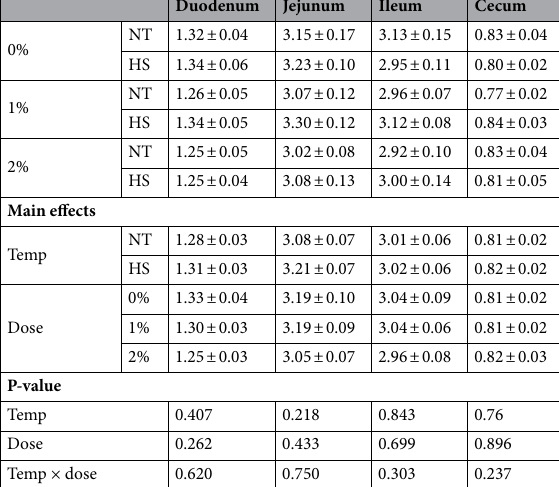
Table 3. Effect of dietary steam-exploded pine particle supplementation on the organ length (cm/100gm body weight) of broilers reared under normal or cyclic heat stress conditions. NT thermoneutral temperature, HS heat stress. Values are presented as mean with standard error (n =